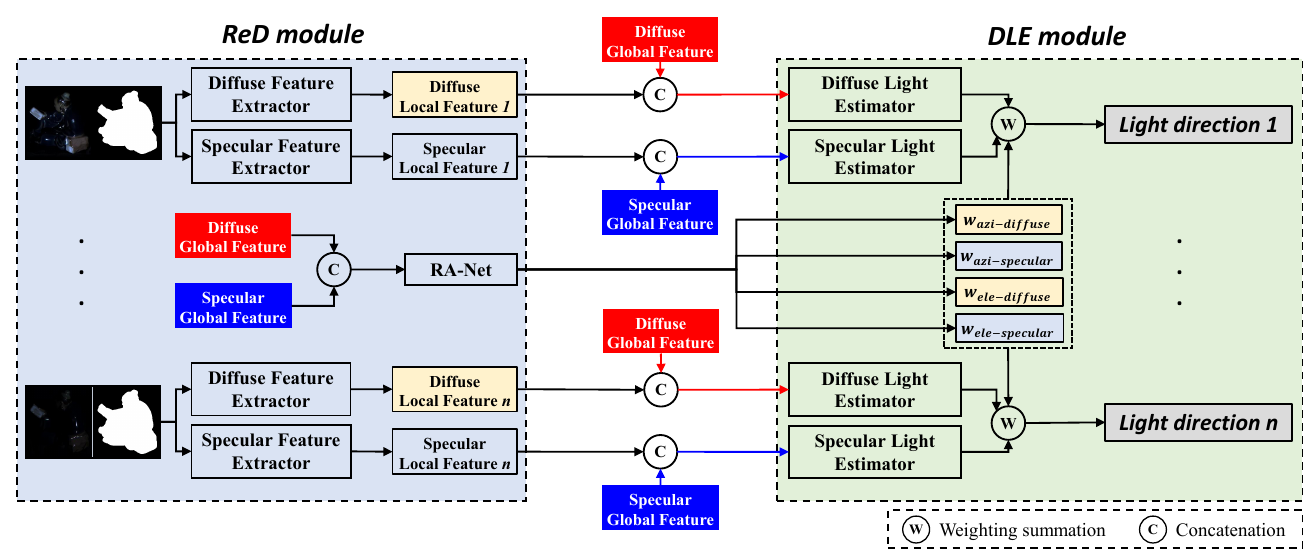
Figure 2. The proposed ReDDLE-Net framework. Our ReDDLE-Net consists of two integrated processing modules, namely, the reflectance decomposition module (ReD module) and the directional light estimation module (DLE module). The ReD module is used to obtain the local diffuse and specular features from pairs of images and masks. Then, max-pooling is utilized to aggregate local features and acquire global features for the diffuse and specular components, respectively (the details of feature aggregation can be found in Figure 3). Taking the concatenation of local features and global features as the input, the reflectance-aware network (RA-Net) produces the reflectance weights, which indicate the proportions of diffuse and specular components. The DLE module fuses the outputs of the ReD module, including the local features, global features, and reflectance weight, to generate the final light direction estimation results.